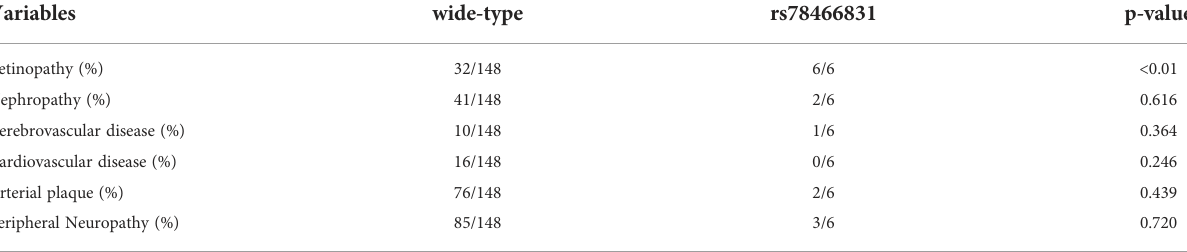
TABLE 5 T2DM-associated chronic complications of the wild-type and rs78466831 patients with